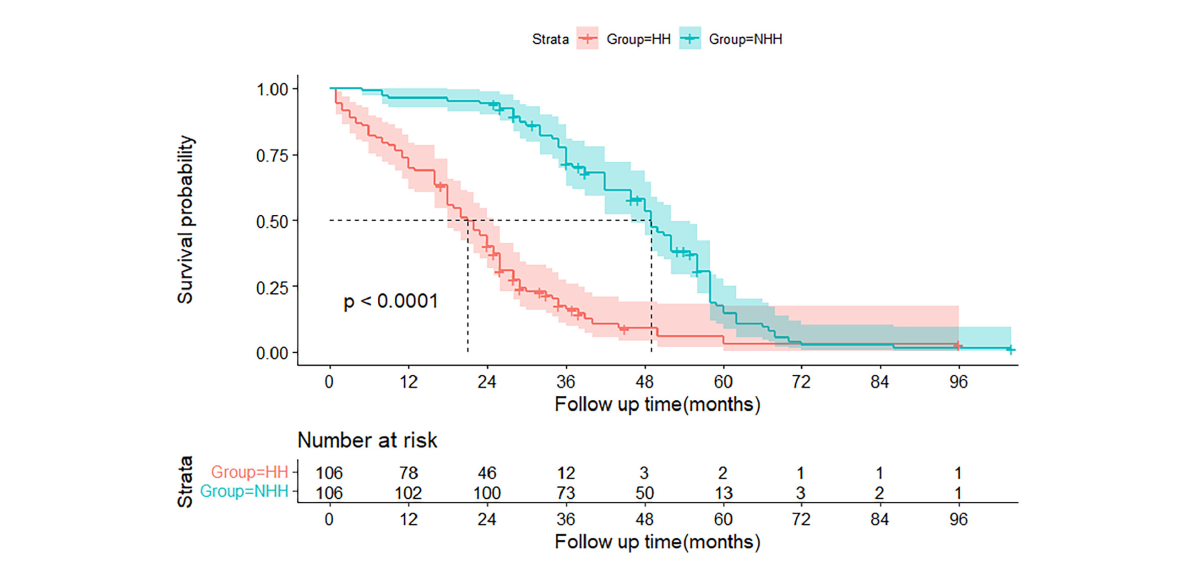
FIGURE2 The Kaplan-Meier graft-free survival curves for the hepatic hydrothorax (HH) and non-HH groups. The 95% confidence interval of the survival probability is marked by the shading. The dotted line indicates the median overall survival. The displayed p values follow from the log-rank test. Every tick mark indicates a censored patient. HH, hepatic